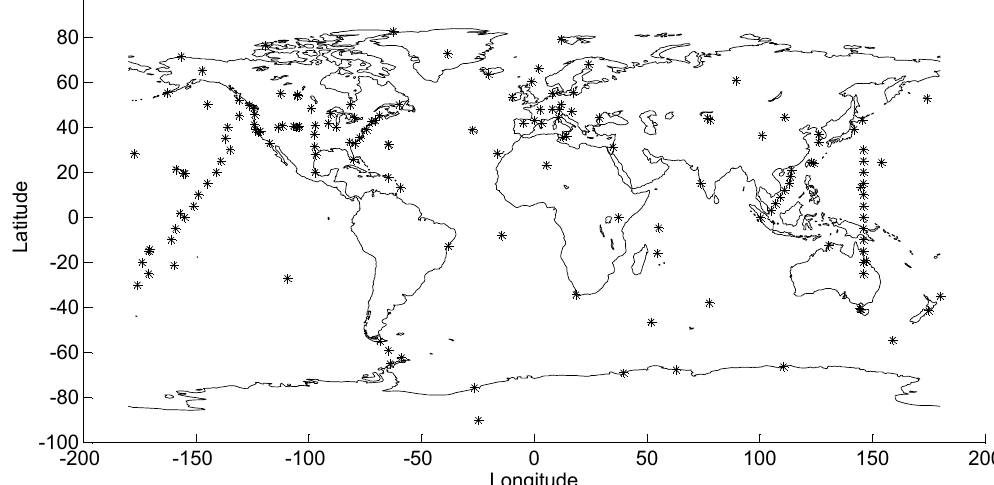
Figure 3. The distribution of 312 stations used in this study. The x axis and y axis stand for longitude and latitude respectively. The asterisk symbol (*) represents the location of